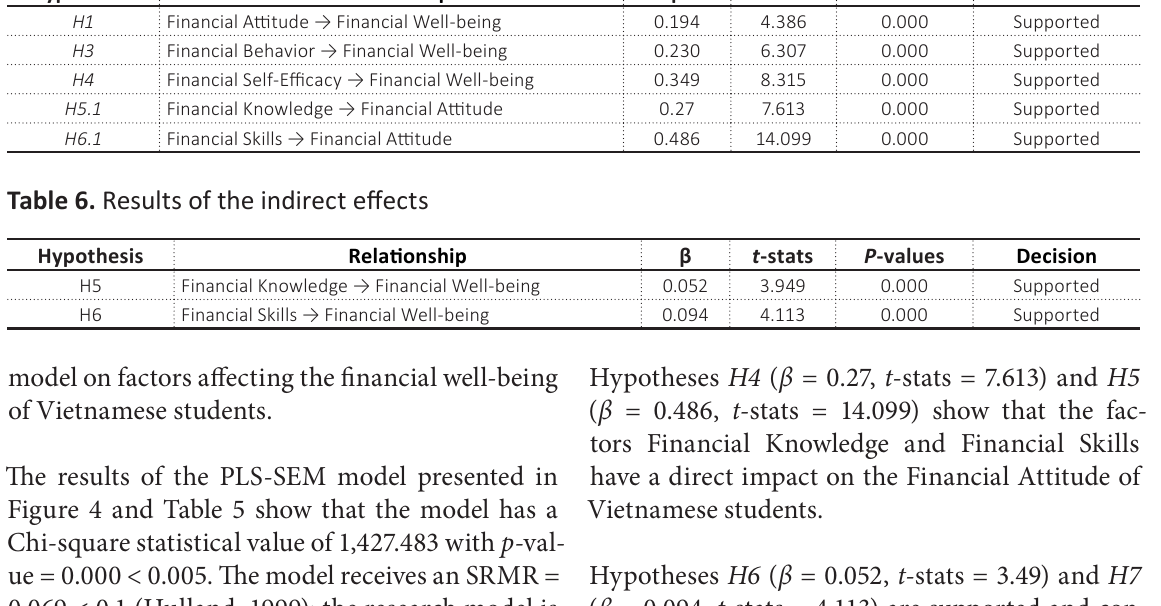
Table 5. Results of the direct effects Hypothesis